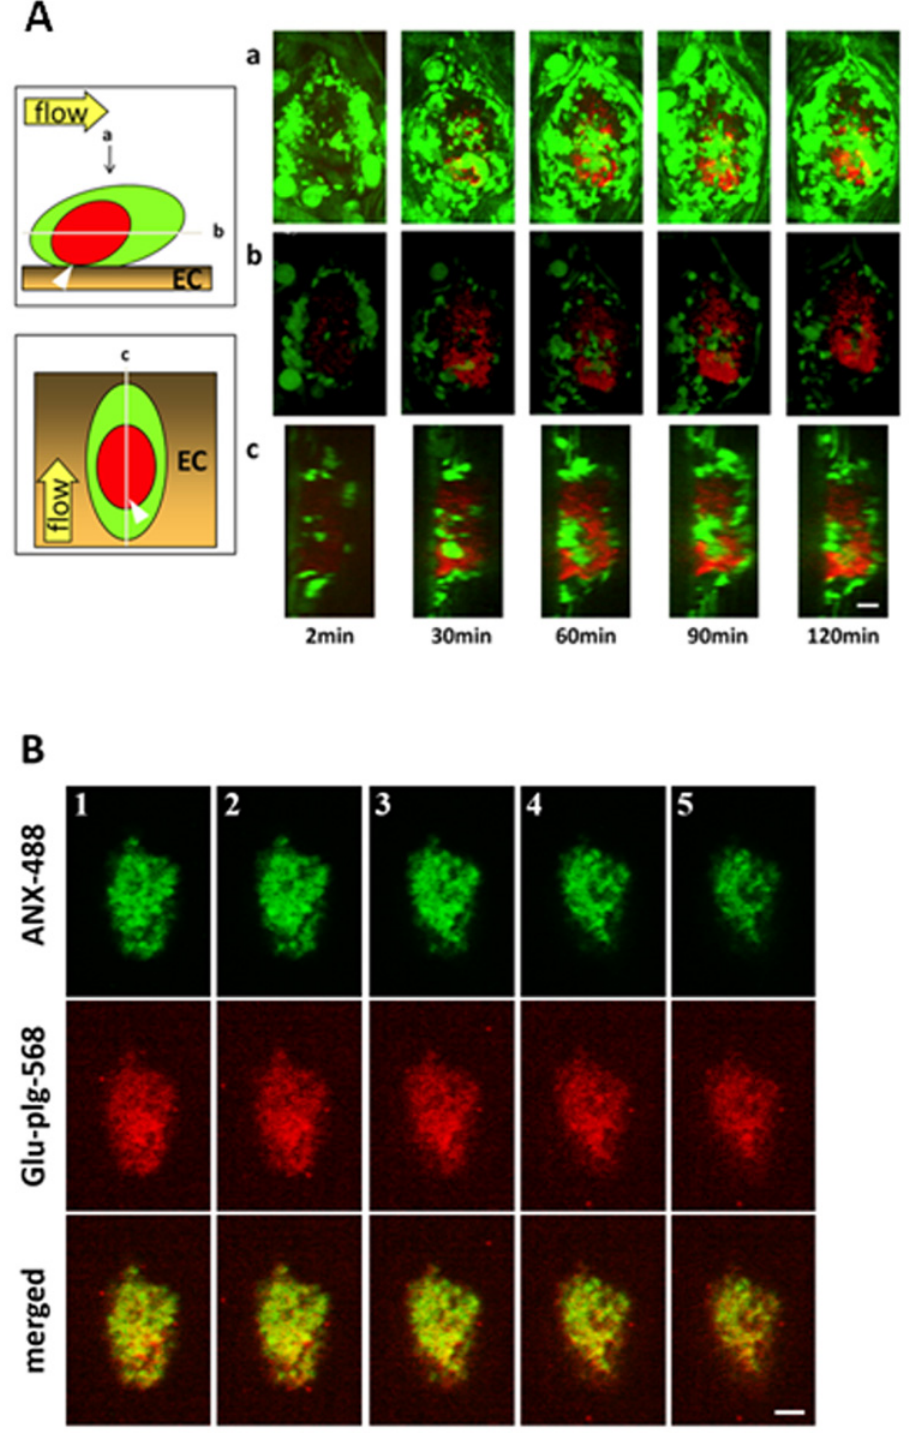
Fig 2. Spatiotemporal distribution of Glu-plg-568 within the microthrombus. (A) Localization of Glu-plg- 568 in a microthrombus in a GFP mouse. a) images of the whole thrombus from the luminal side. b) horizontal plane (X-Y) images at the point where the area of Glu-plg-568 was the largest. c) perpendicular plane (Y-Z) images at the point of the longest Y- axis. Images were taken at 2, 30, 60, 90, and 120 min after laser injury. The schematic depiction shows the horizontal and vertical planes of a laser-induced thrombus